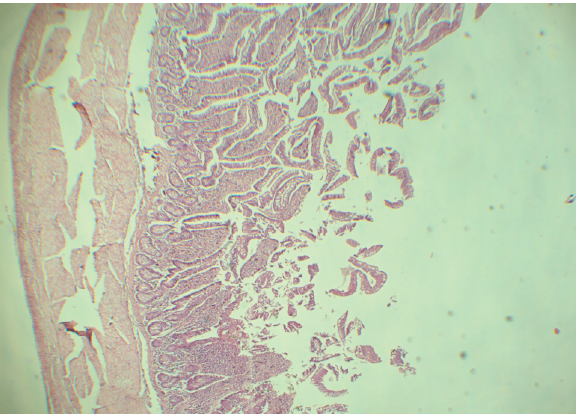
Figure 2. Intestinal epithelium of broiler treated with 1% burdock meal and Bifidobacterium (Group T2). Hematoxylin- eosin. Note intense destruction of the intestinal